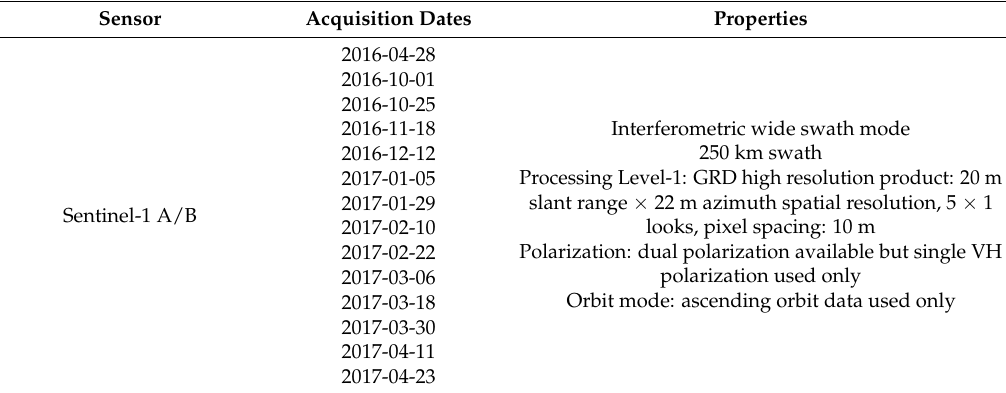
Figure 2. Visualization of extreme phenology in combination with sub-canopy fires in the Miombo forest in Malawi mapped with Sentinel-2. All images with same LUT stretch (R = SWIR, G = NIR, B = Red) Subset of the study area, location of this subset is shown in Figure 1. Table 2. Input data and data